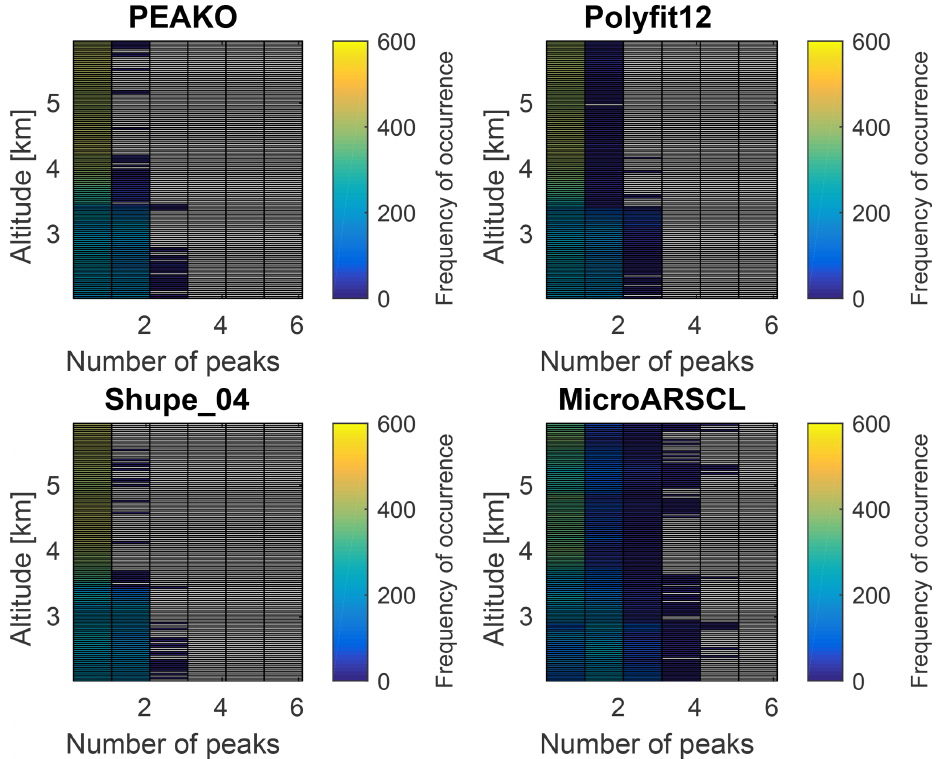
Figure 6. Contoured frequency by altitude diagram (CFAD) for the frequency of occurrence of number of detected peaks from different algorithms for the case study period on 21 February 2014 from 22.54 to 22.77UTC at 2 to 6km